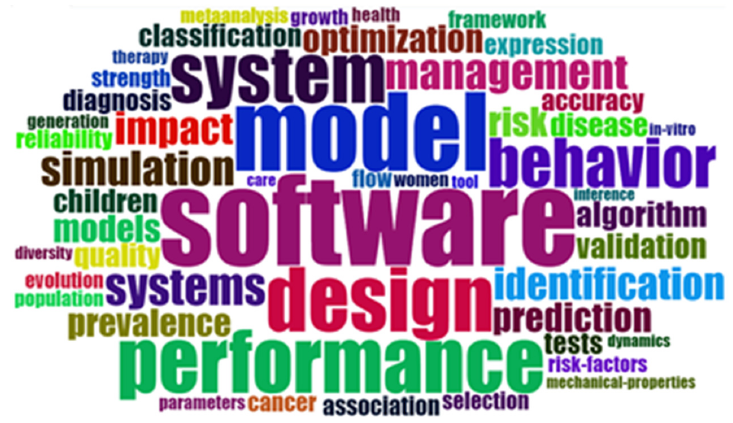
Figure 12. Word Cloud comprising top 50 most common words for the years 2016–2018.